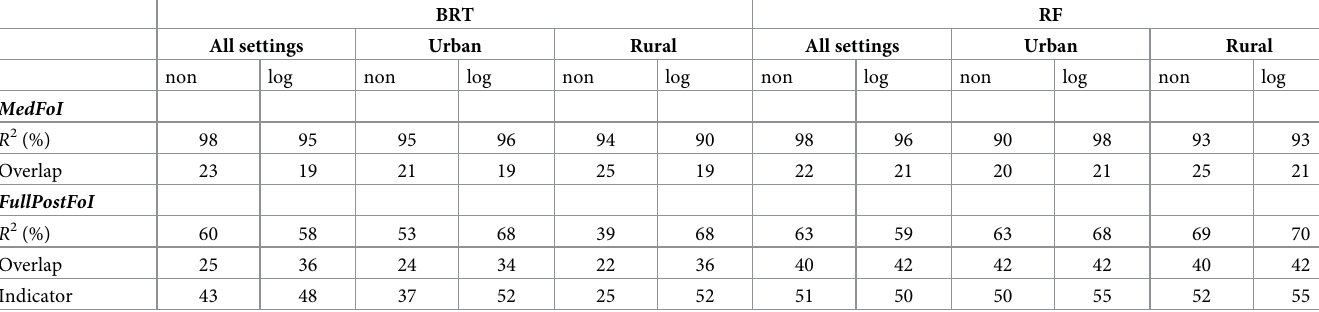
MedFoI : models fitted on median FoI; FullPostFoI : models fitted on full posterior FoI, without (non) or with log-transformation (log) of Force-of-infection (FoI) ‘observations’ (generated by fitting catalytic models to age-stratified serological surveys for Chagas disease in Colombia, with yearly-varying FoI [8]). BRT: Boosted Regression Trees; RF: Random Forest methods; performance indicators are reported for either all settings (urban, rural, indigenous and mixed), urban, or rural settings separately. The predictive R 2 values were calculated on cross-validation datasets and are expressed as percentage. Overlap: proportion (expressed as percentage) of ‘observed’ and predicted distributions that overlaps (reflective of the degree of dispersion around central tendency). For MedFoI models, the performance indicator is the value of R 2 alone. Therefore % overlap is presented for comparison but was not used in fitting or selecting models. For FullPostFoI , the performance indicator is the arithmetic mean between R 2 and % of overlap (see Fig